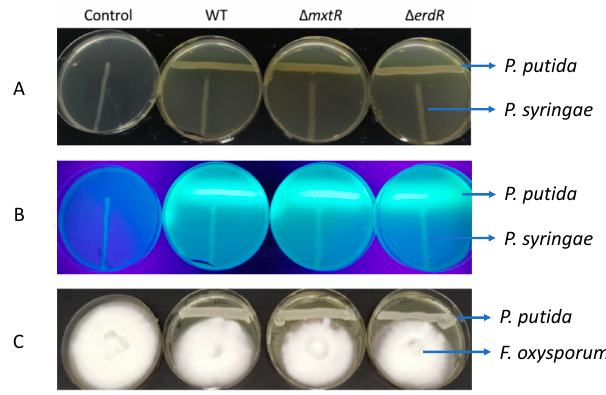
Figure 3. Effect of Δ mxtR and Δ erdR deletion in the biocontrol properties of P. putida KT2440 . The inhibitory effect of WT, Δ mxtR , and Δ erdR on the growth of P. syringae on LB agar plates ( A , B ) and